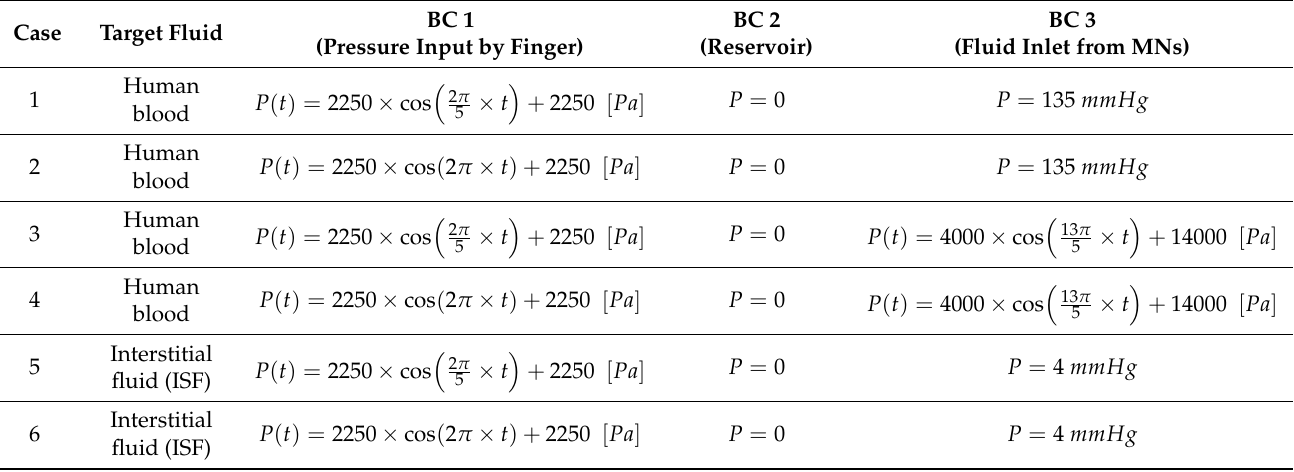
Table 3. The simulated cases of the present study for two different fluids and various boundary conditions